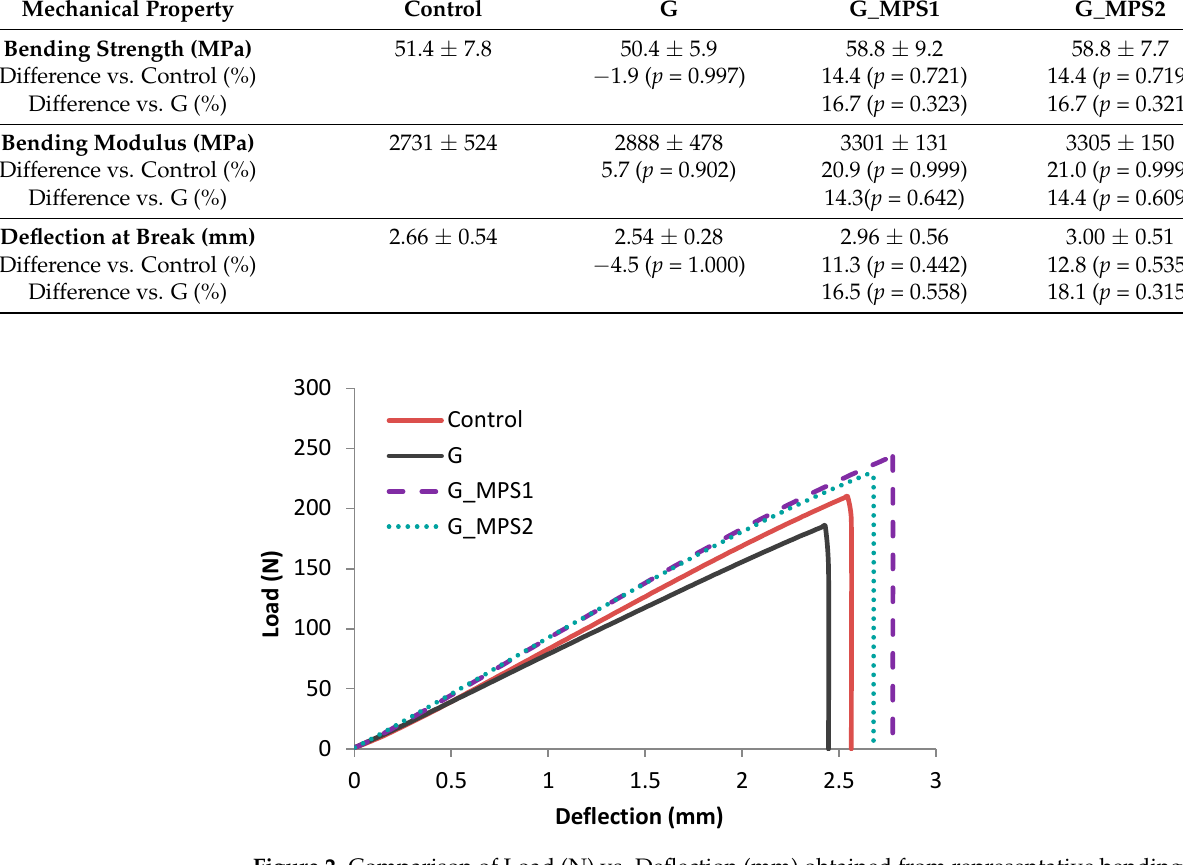
Table 1. Bending properties and cycles to fatigue failure (mean ± SD) for control and bone cements with 0.1 wt.% of graphene (G) and silanised G obtained from G_Oxi1 (G_MPS1) and from G_Oxi2 (G_MPS2). The difference of each value compared with control and with G of each cement is given in %.